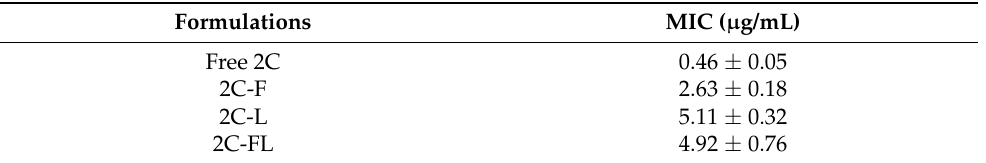
Table 4. In vitro antifungal activity of free 2C and 2C-encapsulated formulations against C. albicans as determined from minimum inhibitory concentration (MIC)